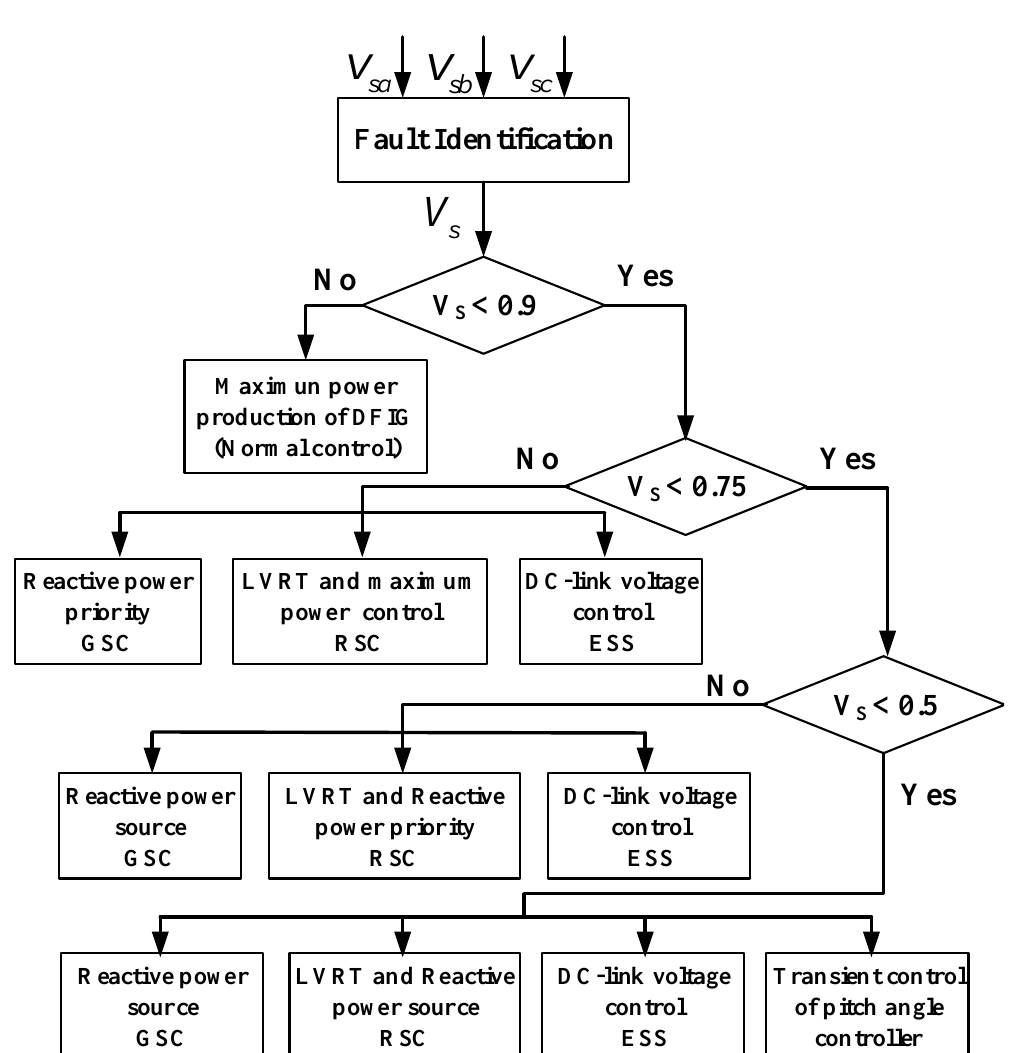
Figure 3. Flow chart of the integrated low voltage ride-through (LVRT) and enhanced reactive power support